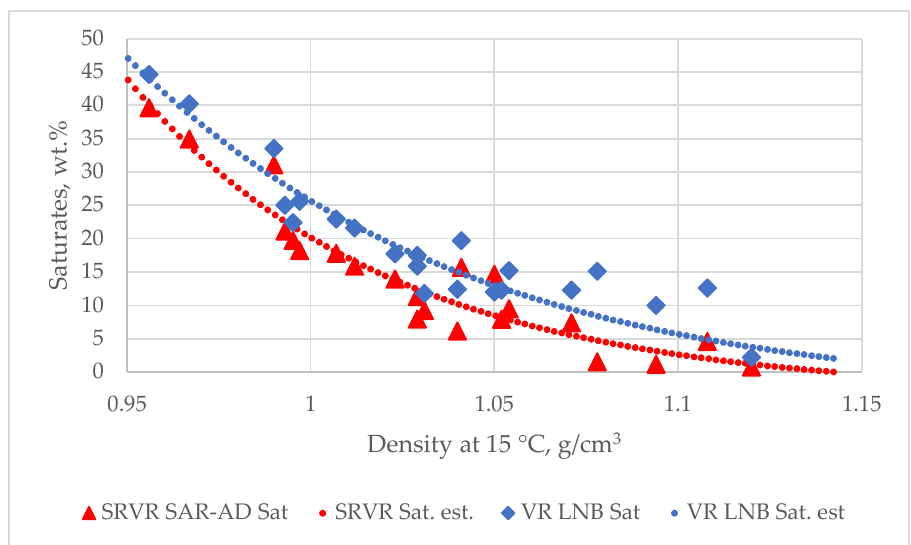
Figure 1. Relation of straight run vacuum residue density to saturate content determined by SAR- AD TM and LNB SARA methods.